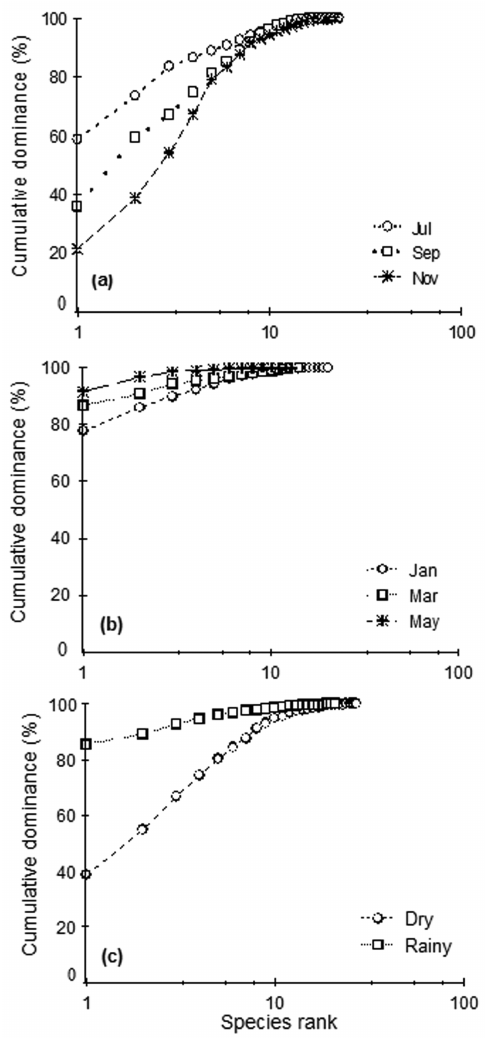
Fig. 4 – Cumulative dominance curves of copepods for dry (a) and rainy (b) sampling months and for the two seasons (c) in the Curuçá